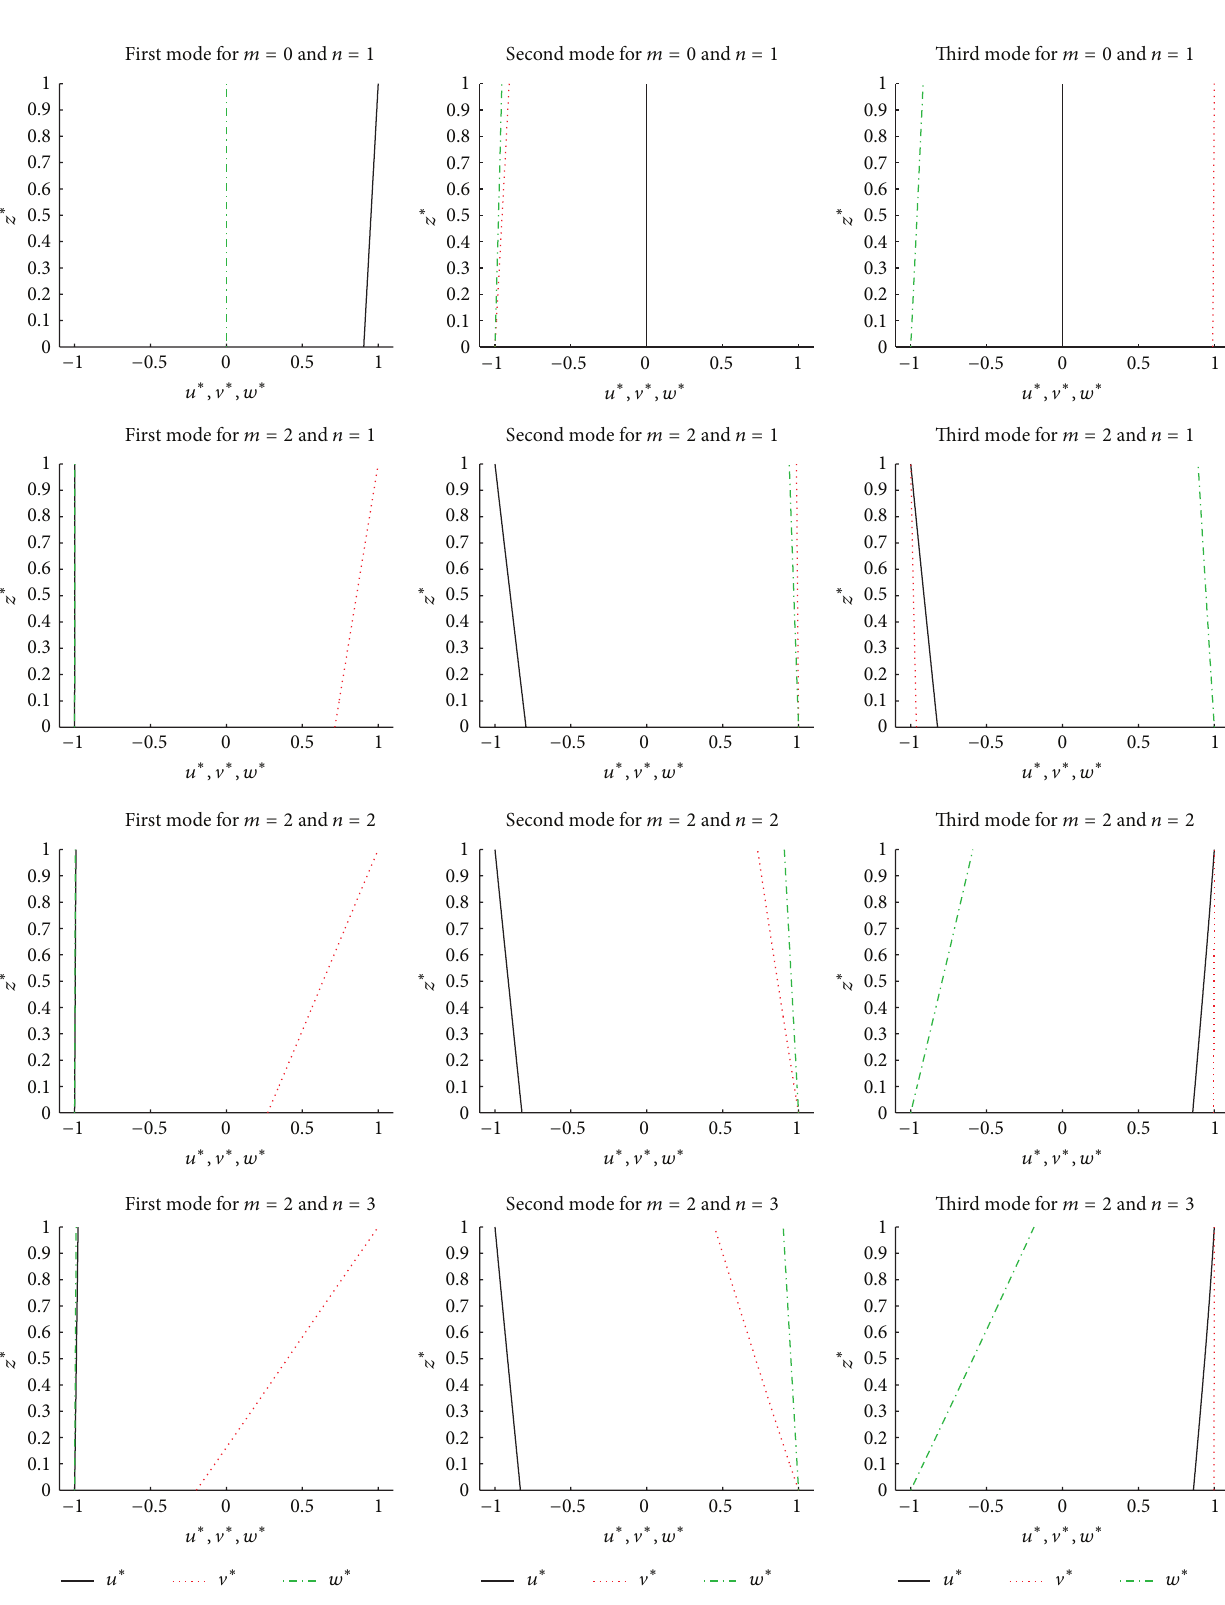
Figure 9: Benchmark 8, simply supported orthotropic cylinder (𝜃 = 90 ∘ ). First three vibration modes in terms of displacement components through the thickness for thickness ratio 𝑅 𝛼 /ℎ = 10 and several combinations of half-wave